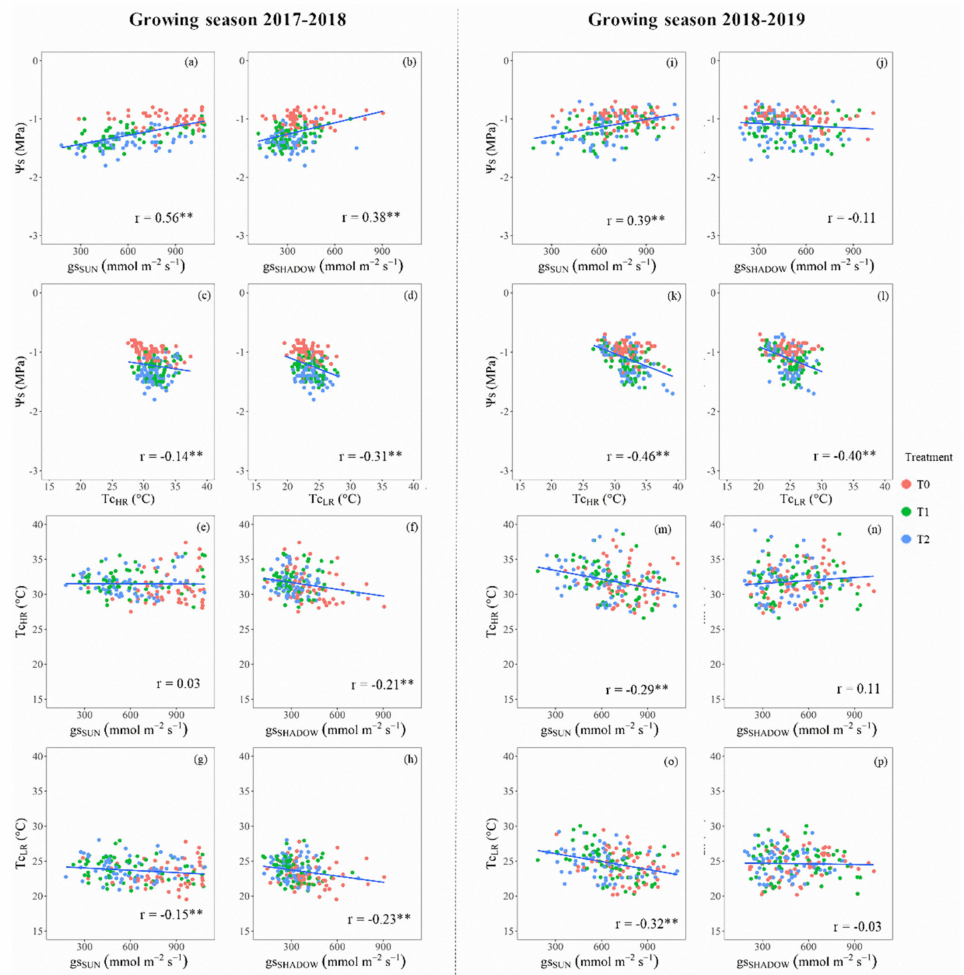
Figure 4. Linear relationships among average values of midday stem water potential ( Ψ s), stomatal conductance(gs)forsunlit(SUN)andshaded(SHADOW)leaves, andcanopytemperature(Tc)forcherry trees ‘Sweetheart’, for each post-harvest irrigation treatment (control: T0 ( Ψ s ≥ − 1.0 MPa); low–medium water stress: T1 ( − 1.0 ≥ Ψ s ≥ − 1.5 MPa), and high (severe) water stress: T2 ( − 1.5 ≥ Ψ s ≥ − 2.0 MPa). Subscripts HR and LR, denote that the thermal images were shot from a high- and low-resolution TIR camera. Growing seasons 2017–2018: left side, and 2018–2019: right side. Levels of significance: 0.01